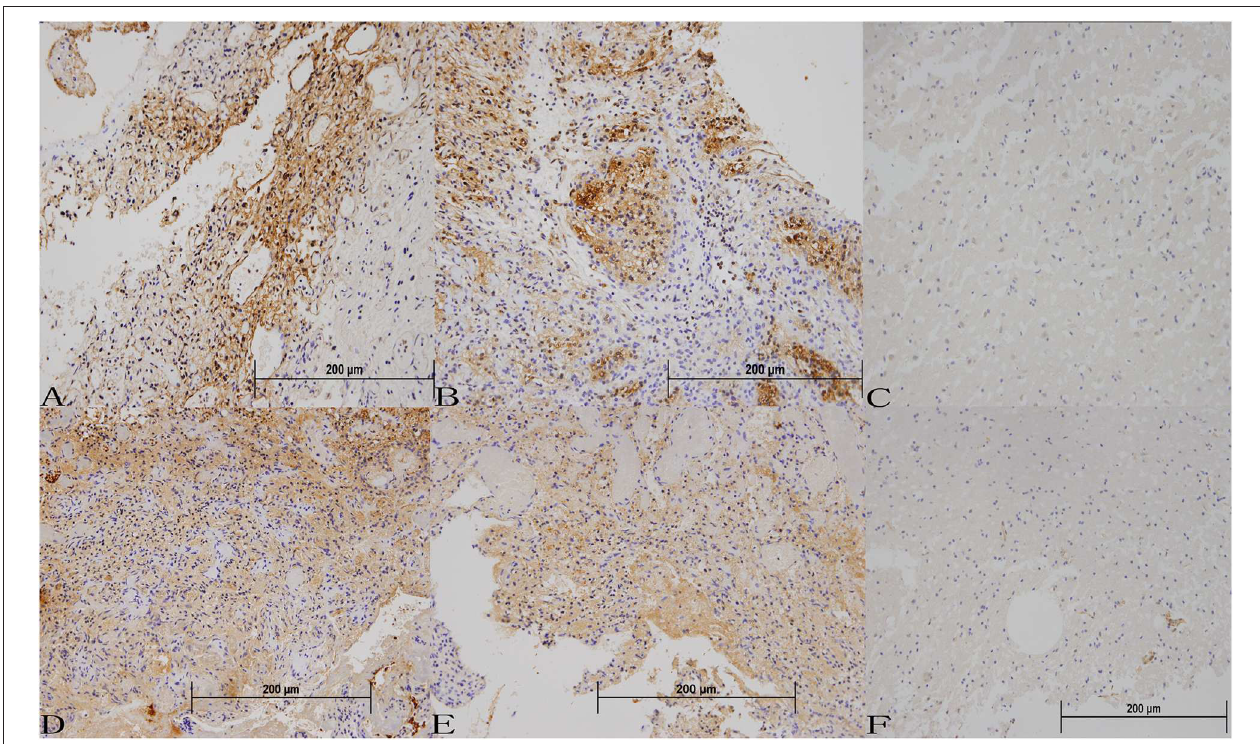
FIGURE 1 | Protein expression of EGFR and TGF α in VHL-related hemangioblastoma tissues (A–C) Immunohistochemical staining for EGFR in VHL-related hemangioblastoma tissues (200 × ). (D–F) Immunohistochemical staining for TGF α in VHL-related hemangioblastoma tissues (200 × ).